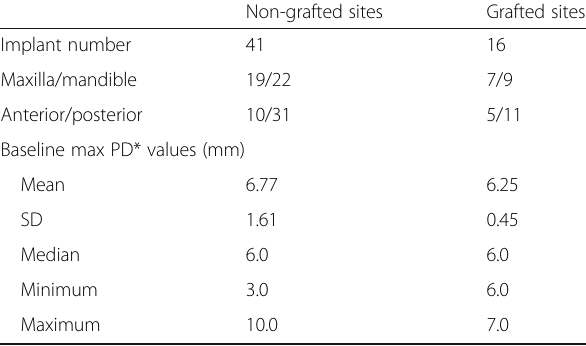
Table 1 Implant site characteristics